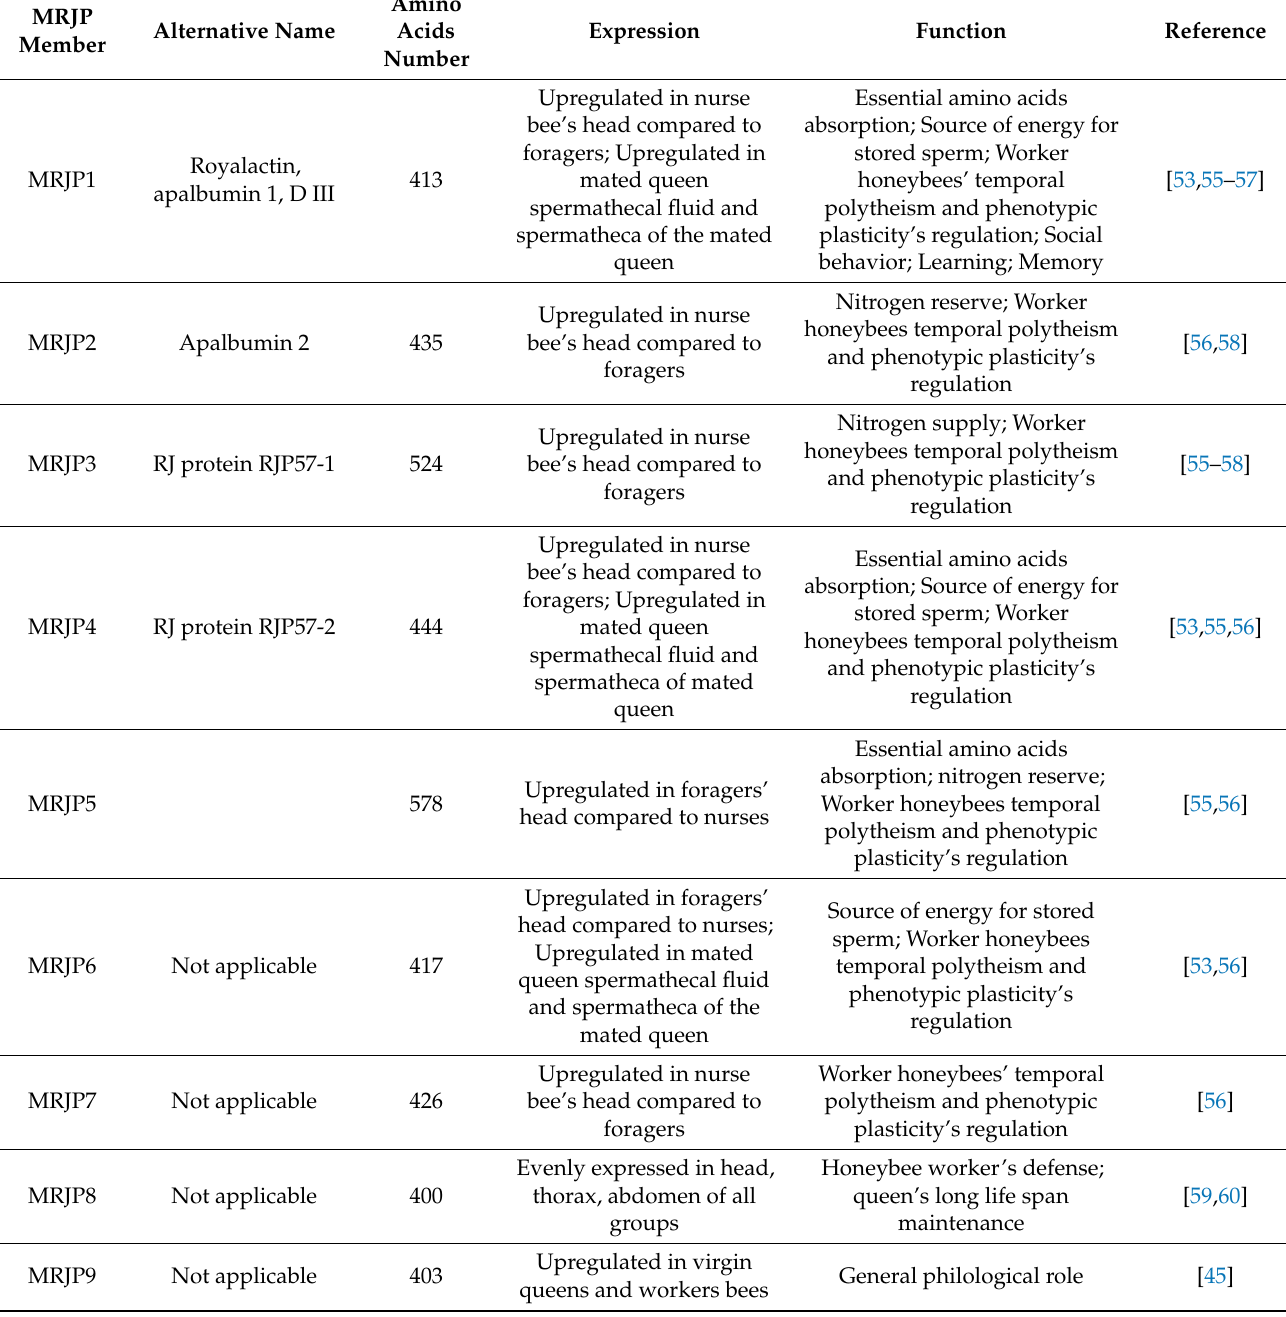
Table 3. MRJP 1-9 brief